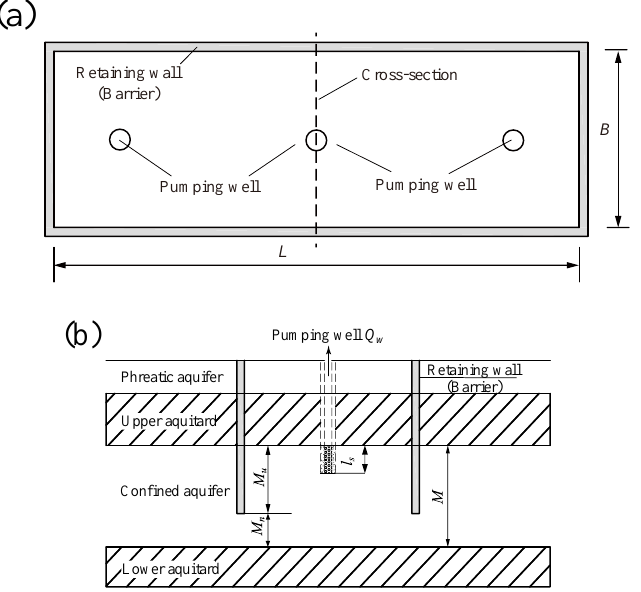
Figure 3. Problem sketch: ( a ) plan view of the rectangle excavation pit; ( b ) cross-section view of barriers